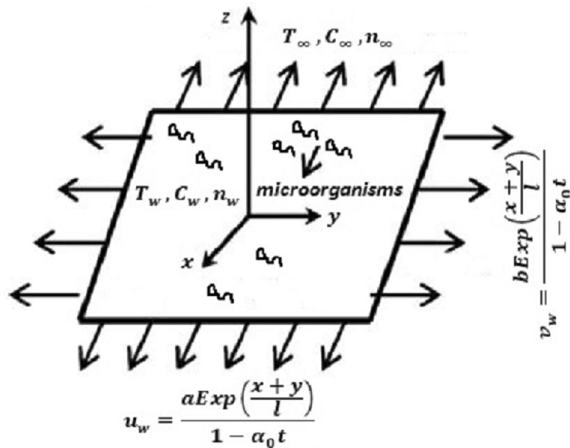
Figure 1. Physical picture of the